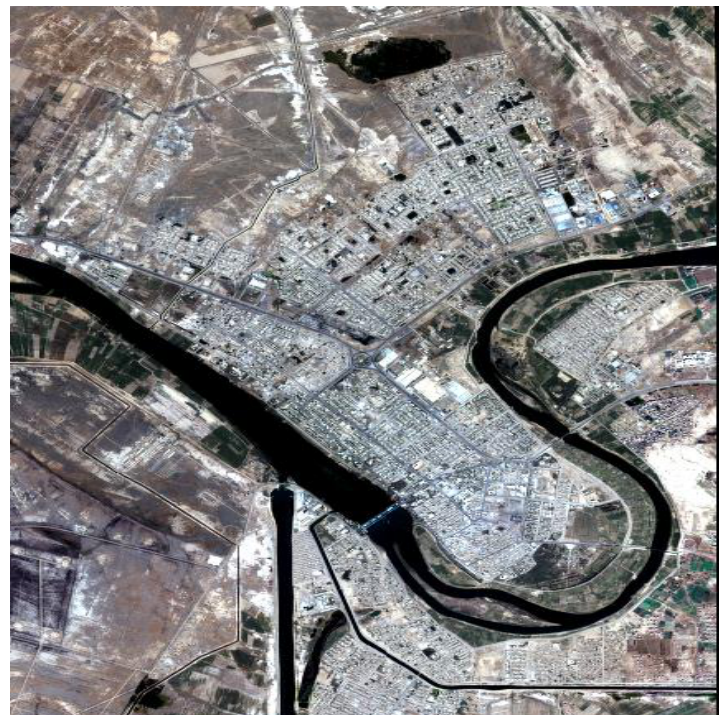
Fig.4: Producing QuickBird satellite image with high resolution.